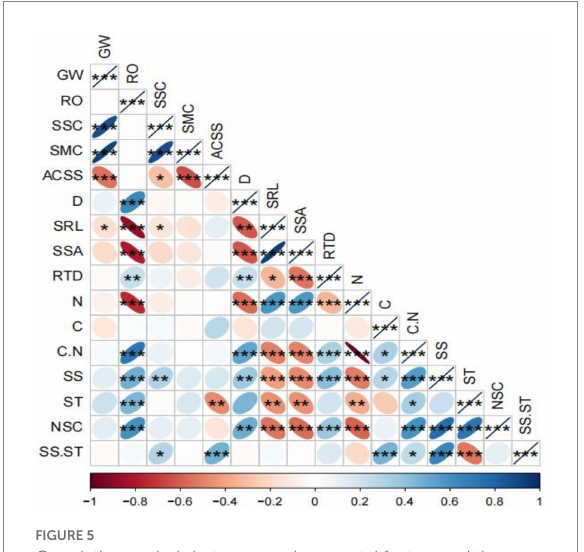
FIGURE 5 Correlation analysis between environmental factors and the morphology and chemical indices of the fine roots of Tamarix chinensis. * p < 0.05; ** p < 0.01; *** p < 0.001. WG, groundwater level; RO, root order; SSC, soil salinity content; SMC, soil moisture content; ACSS, soil solution absolute content; D, fine root average diameter; SRL, specific root length; SSA, specific surface area; RTD, root tissue density; N, nitrogen; C, carbon; C/N, nitrogen/carbon; SS, soluble sugar; ST, starch; NSC, nonstructural carbohydrate; SS/ST, soluble sugar/starch. The same applies